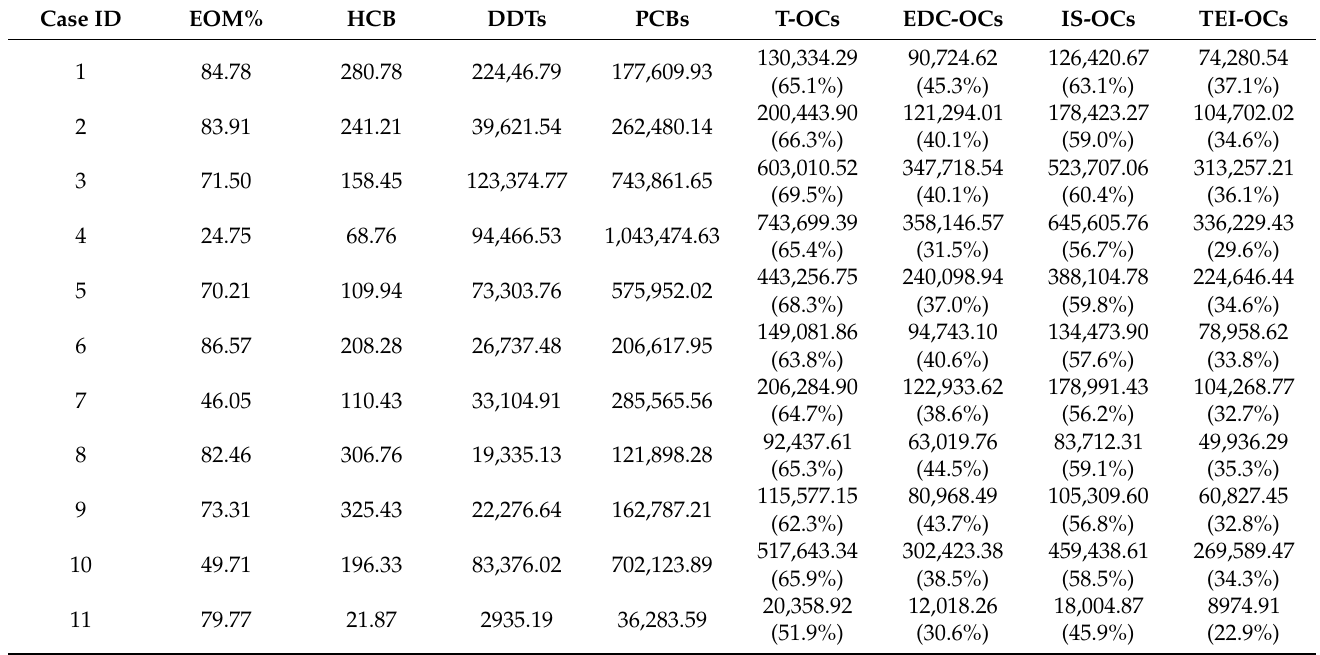
Table 4. Levels of HCB, DDTs, PCBs, T-OCs, EDC-OCs, IS-OCs, and TEI-OCs in the blubber of differ- ent specimens of Tursiops truncatus (Case ID) expressed in ng/g dry weight (d.w.) For T-OCs, EDC- OCs, IS-OCs, and TEI-OCs, the respective percentages of total OCs are reported. EOM% = Extracted Organic Material